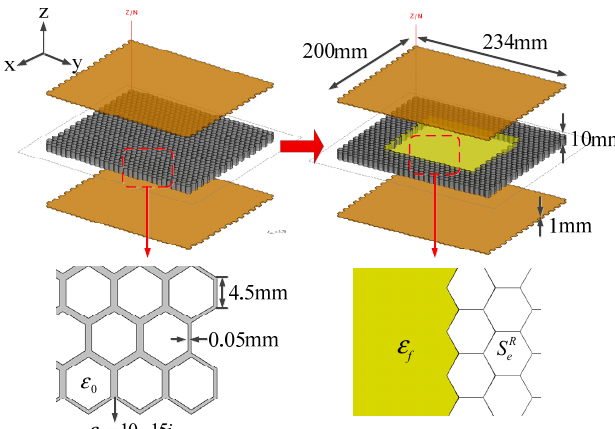
Figure 9. Geometry illustration of the sandwich structure containing microwave-absorbing core.